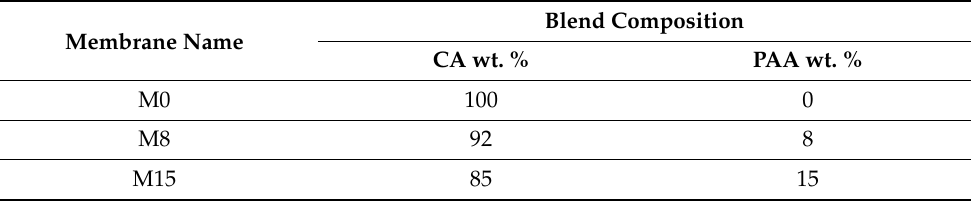
Table 1. Composition of the polymeric solutions employed for membranes